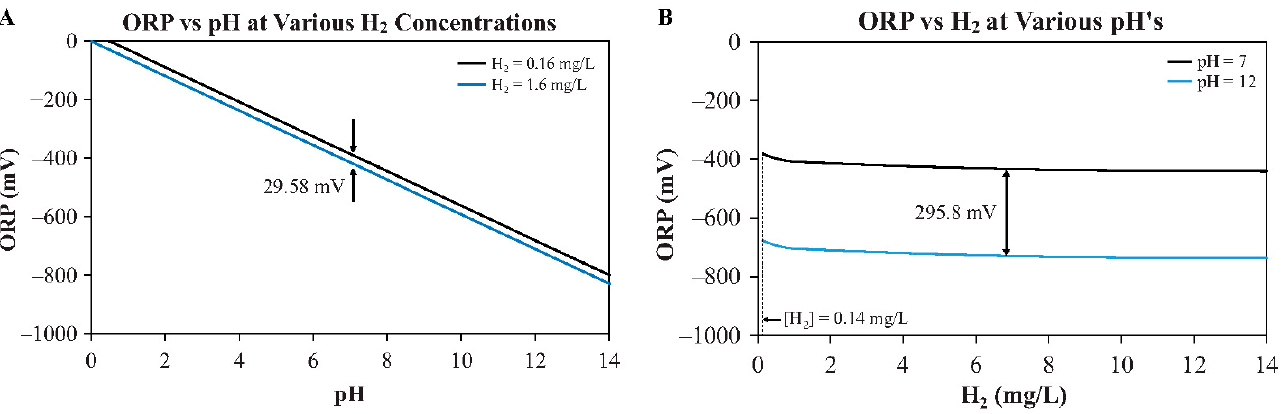
Figure 1. Changes in ORP as a function of either pH ( A ) or H 2 concentration ( B ). Temperature held constant at 25 °C. Note that although the concentration of H 2 at the standard ambient temperature and pressure is 1.6 mg/L, it may be higher than this at lower temperatures and/or higher pressures accordingly to Henry’s law (C = P/K H ; C is concentration, P is pressure, and K H is Henry’s solubility constant for the specific gas at a given temperature).